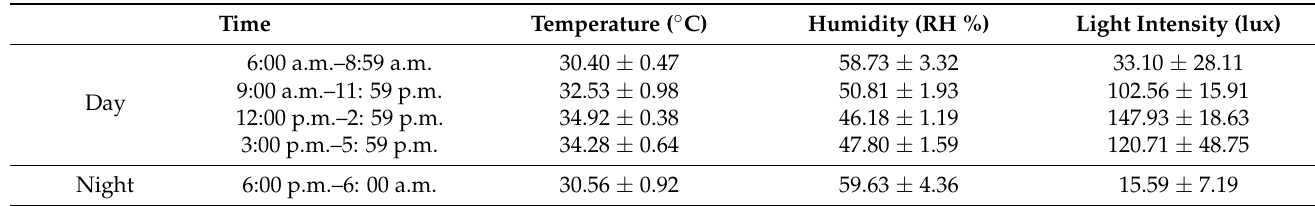
Light Intensity (lux)